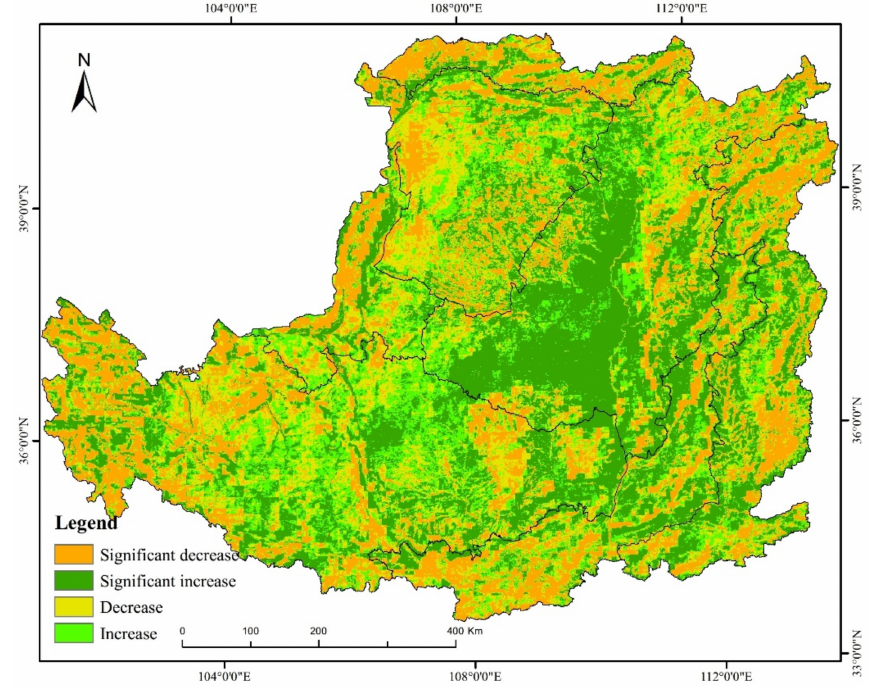
Figure 6. Distribution of significant NDVI changes in the growing season from 1990 to